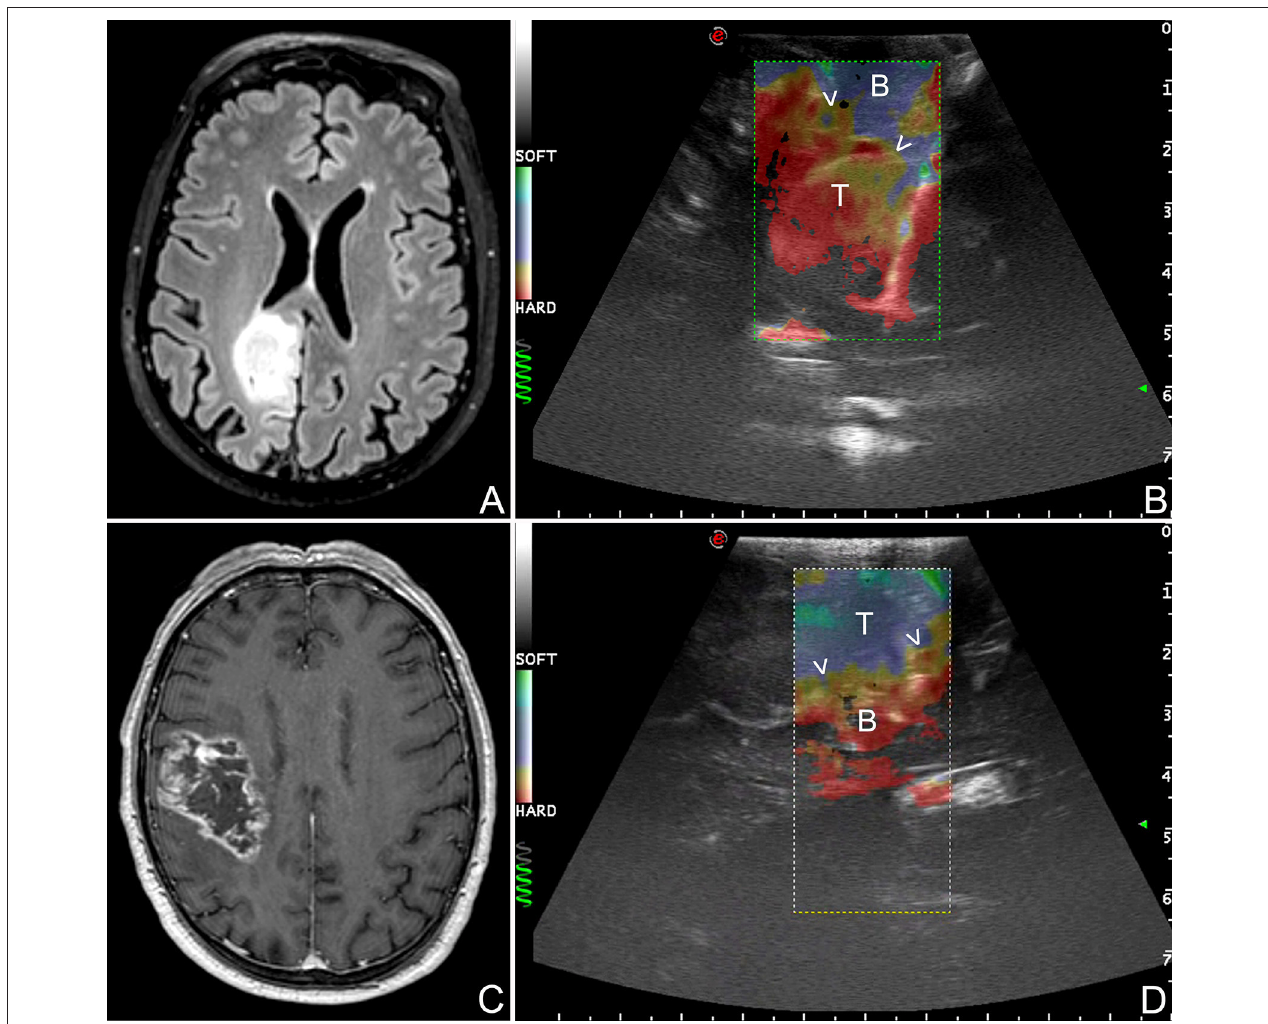
FIGURE 9 | Strain elastography (SE) scans in different glioma grades. (A,B) SE in a case of right parietal low grade glioma. (C,D) SE in a case of right fronto-parietal glioblastoma. SE is able to differentiate between LGG and HGG relying on their stiffness. LGG appear stiffer than brain whereas HGG softer. Furthermore, SE aid in identifying tumor borders and in distinguishing tumor and edema. (T: tumor, B: brain, arrow heads: interface between tumor and surrounding